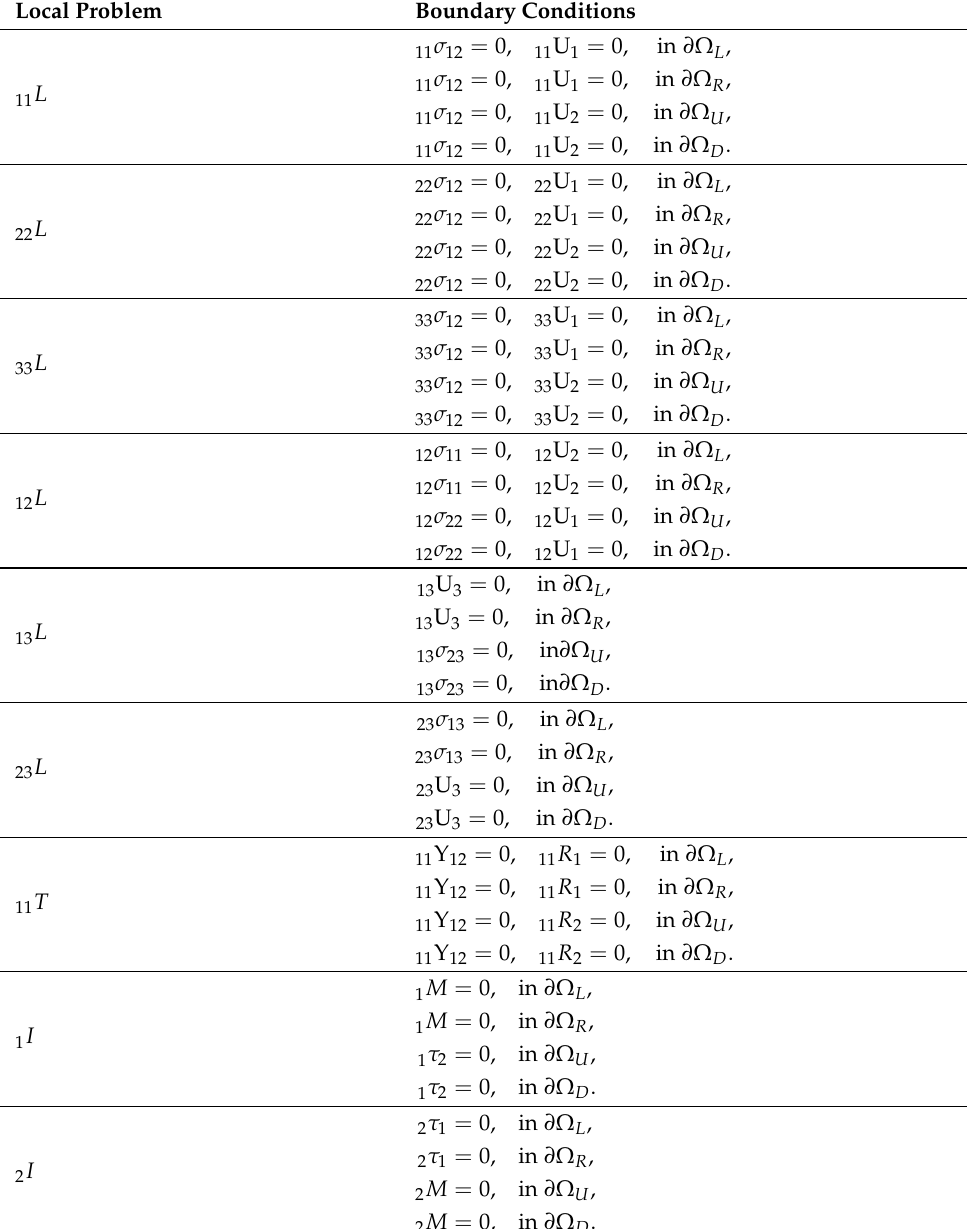
Table A1. Boundary conditions for local